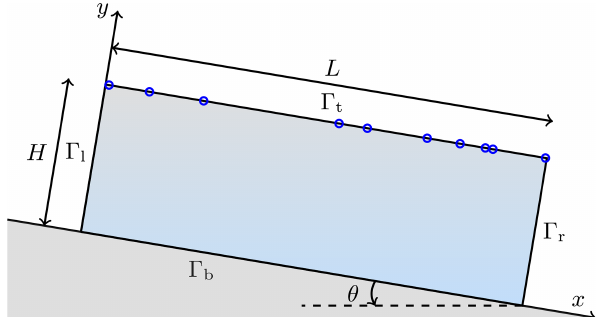
Figure 1. Schematic of a two-dimensional slab of ice (used in ex- amples 1 and 2). The schematic can also be thought of as a cross section through the three-dimensional slab of ice used for Exam- ple 3. The blue circles show representative (random) measurement locations but do not necessarily coincide with the actual measure- ment locations used in the examples. θ is the slope of the ice slab.